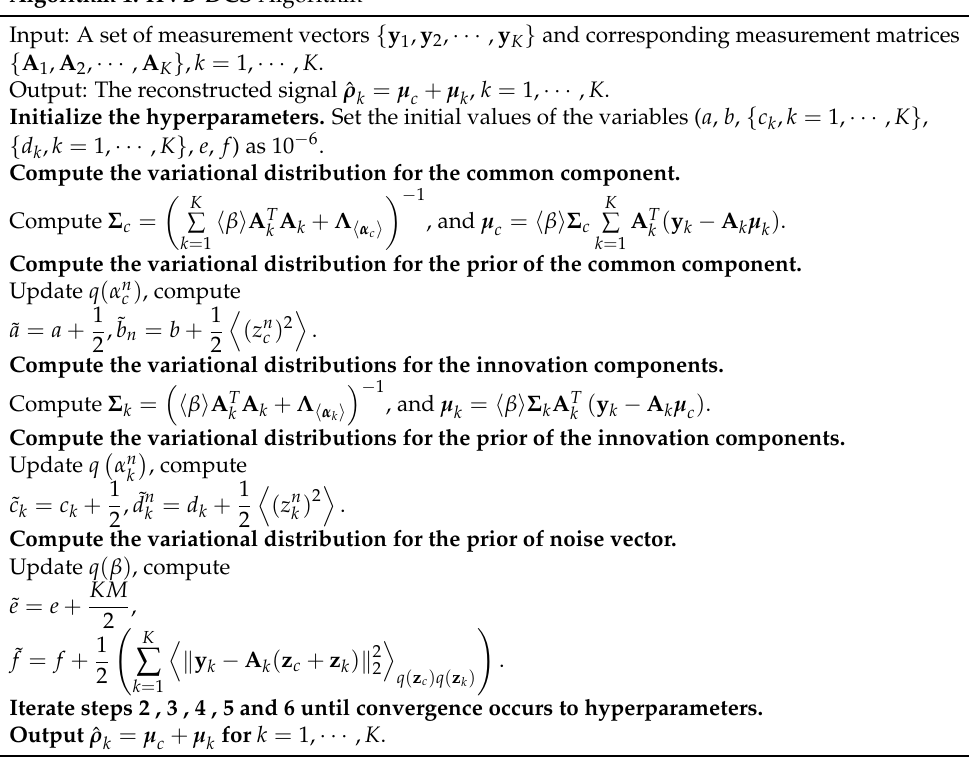
Algorithm 1: HVB-DCS